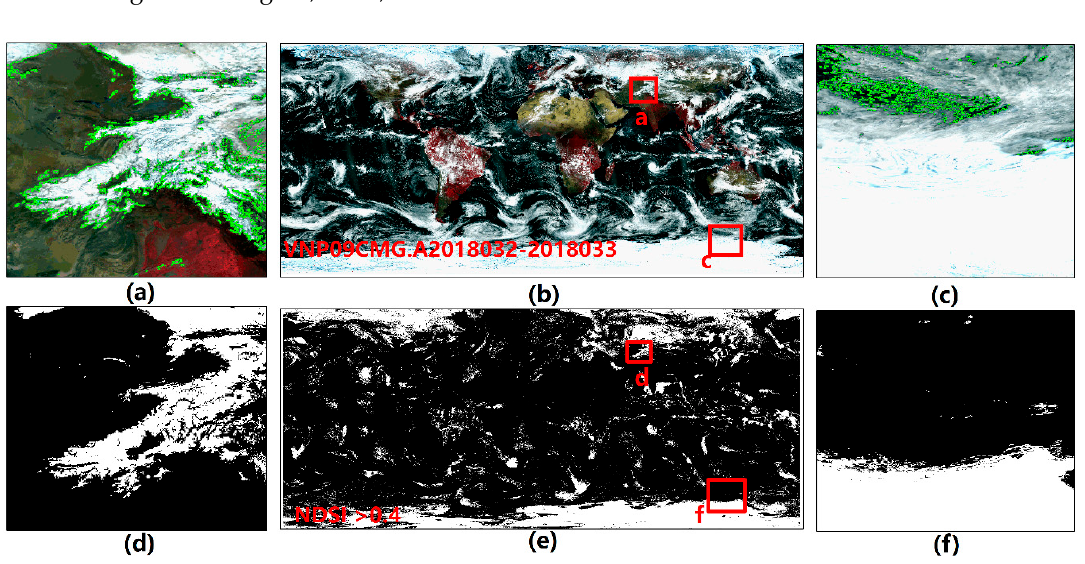
Figure 13. The original map and the snow, ice, and ice cloud detection results obtained for the VIIRS data by using NDSI. Panels ( a - c ) depict the original maps, while panels ( d - f ) present the NDSI results corresponding to panels ( a - c ), respectively. Panel ( a ) and panel ( d ) depict the original maps and the NDSI detection results for snow, ice, and ice cloud over the Pamirs, while Panel ( c ) and panel ( f ) depict the original maps and the NDSI detection results for snow, ice, and ice cloud over the edge of Antarctica.